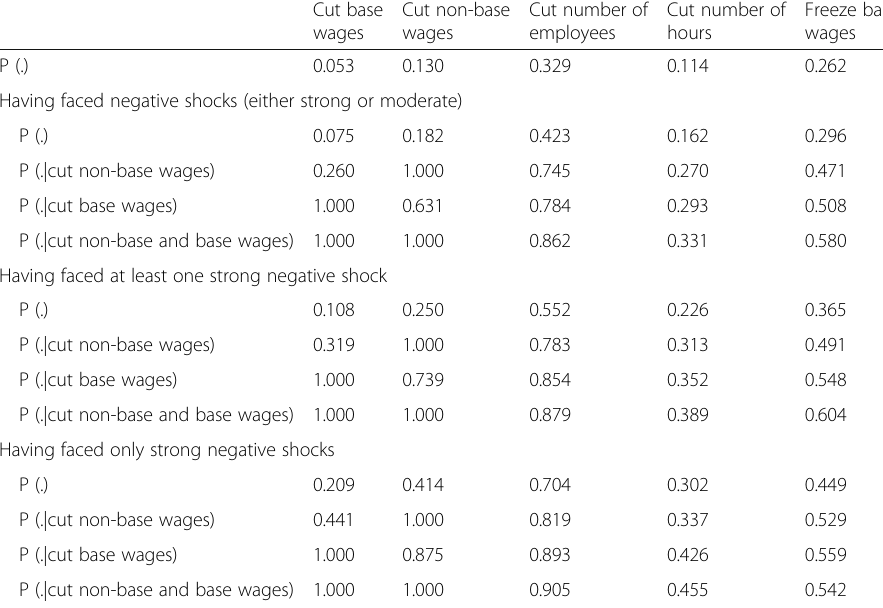
Cut base Cut non-base Cut number of Cut number of Freeze base wages wages employees hours wages